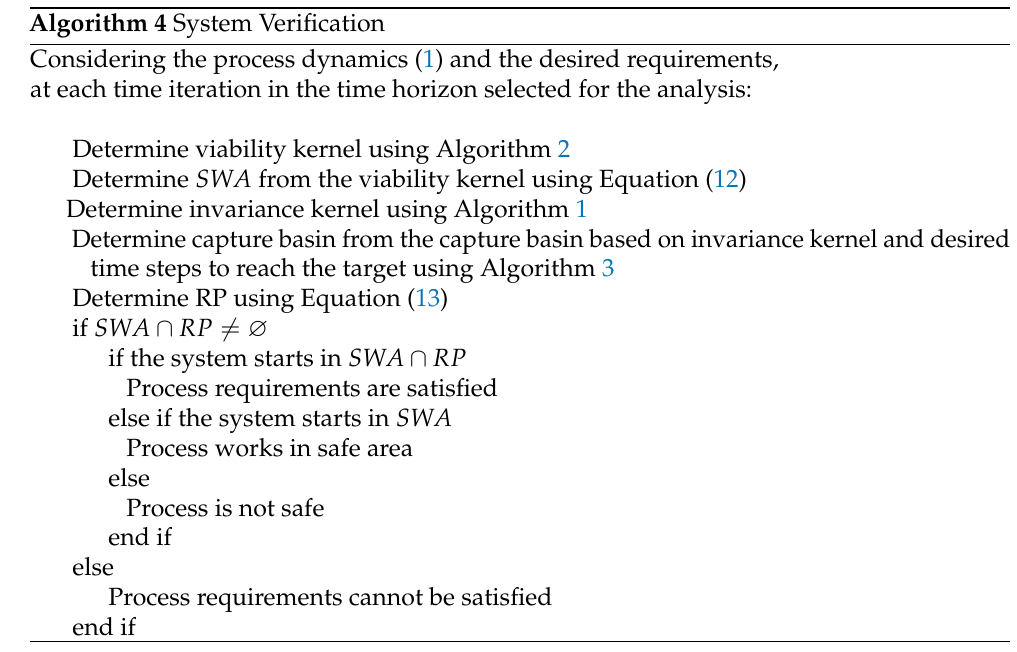
Algorithm 4 System